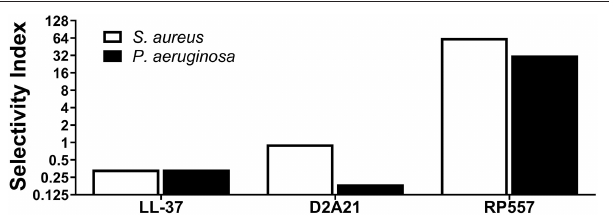
FIGURE 5 | RP557 possesses potent selectivity for bacterial pathogens. The Selectivity Index is defined by the dose required to hemolyze 10% human red blood cells compared to the S. aureus and P. aeruginosa minimal inhibitory concentration (MIC).